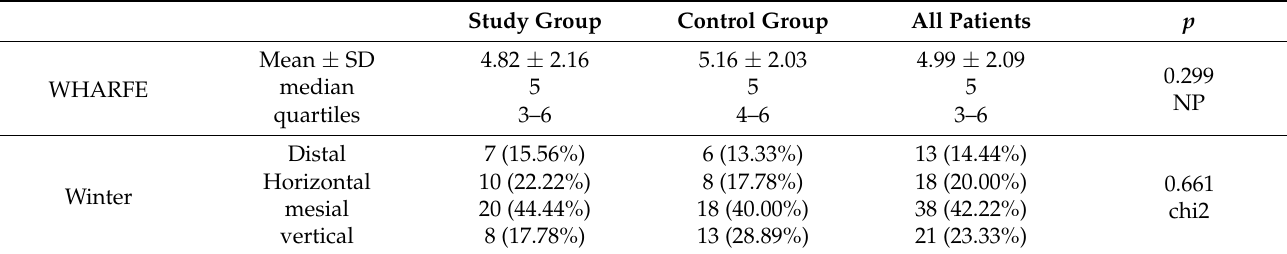
Table 3. Characteristics of the location of lower wisdom teeth and preoperative assessment of the difficulty of its surgical removal according to